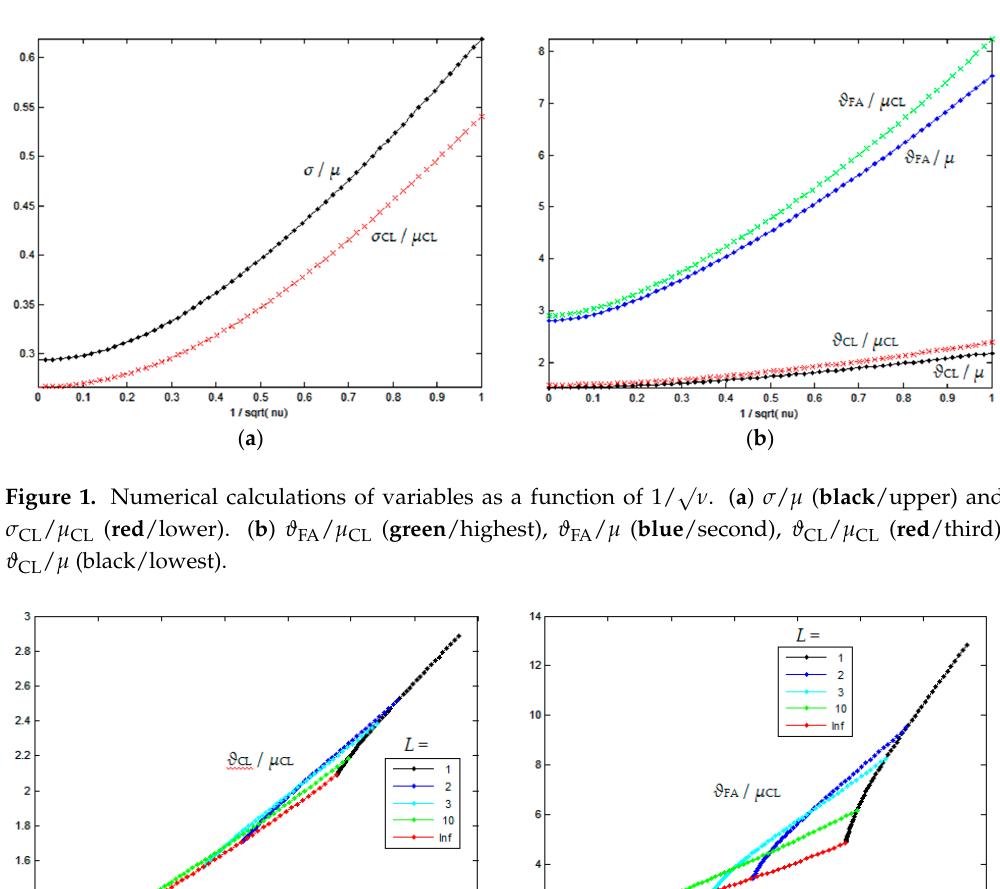
Figure 2. The direct lookup tables from the clipped standard deviation divided by the clipped mean ( σ CL / µ CL , which is calculated from the data as S N,CL ), to ( a ) the clipping threshold divided by the clipped mean ϑ CL / µ CL and ( b ) the detection threshold divided by the clipped mean ϑ FA / µ CL , which can both be applied directly to the data as ϑ N,CL and ϑ N,FA . Five plots are included, for values of L = 1, 2, 3, 10, ∞ , from right to left, in black, blue, cyan, green and red. Each of these has only a limited range of existence in σ CL / µ CL .